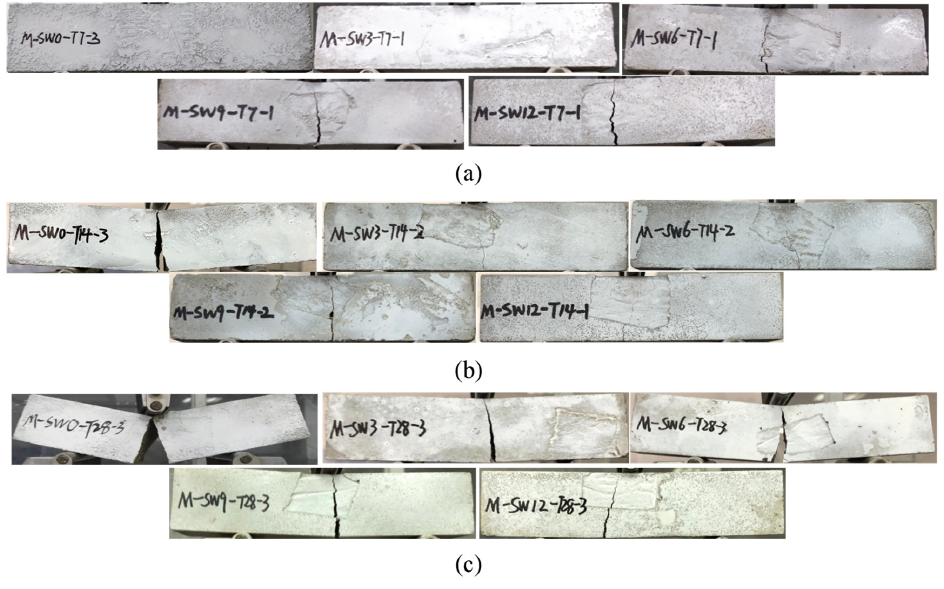
Figure 5. Failure modes. ( a ) T7; ( b ) T14; ( c ) T28.